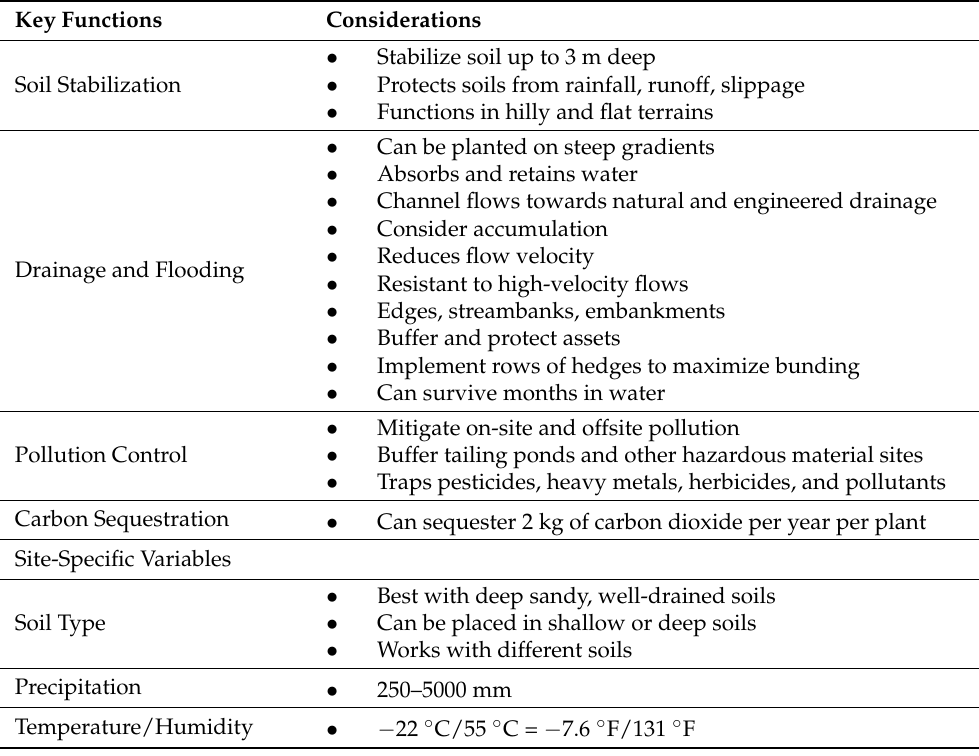
Table 1. Key Factors and Considerations for Implementing Vetiver as a Green Infrastructure Tool. Key